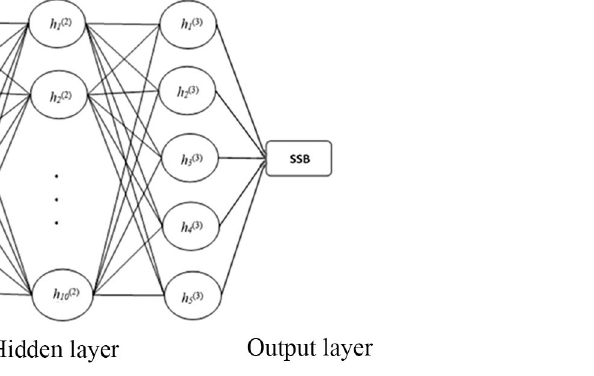
Fig 1. Stacked-autoencoder neural network